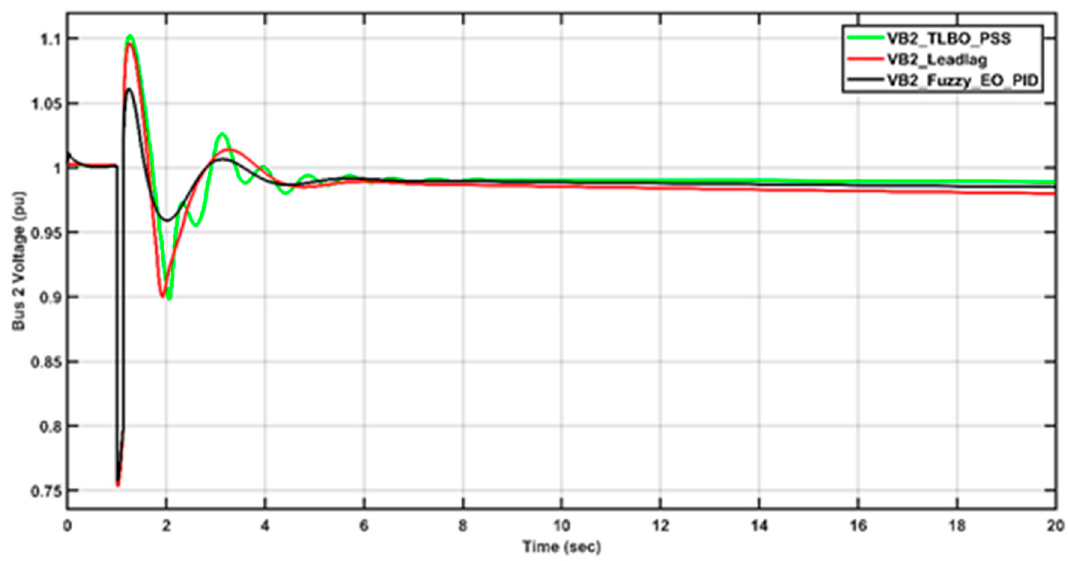
Figure 19. Bus 2 voltage results for Kundur system.